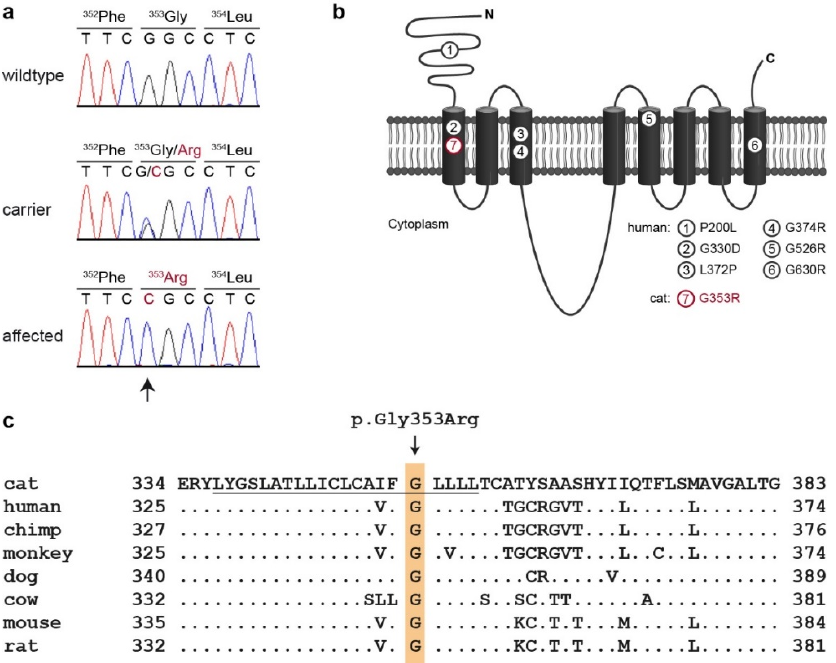
Figure 4. Details of the SLC39A4 :c.1057G > C, p.Gly353Arg variant. ( a ) Representative electropherograms of three cats with different genotypes are shown. The variable position is indicated by an arrow and the amino acid translations are shown. ( b ) Model of SLC39A4 membrane topology, modified from [39]. The positions of six functionally characterized missense variants identified in human AE patients are indicated. The position of the feline p.Gly353Arg variant identified in the investigated cat is indicated in red. ( c ) Multiple-species alignment of the SLC39A4 amino acid sequences in the region harboring the p.Gly353Arg variant. The variant affects a highly conserved glycine residue. The sequence of the first transmembrane domain is